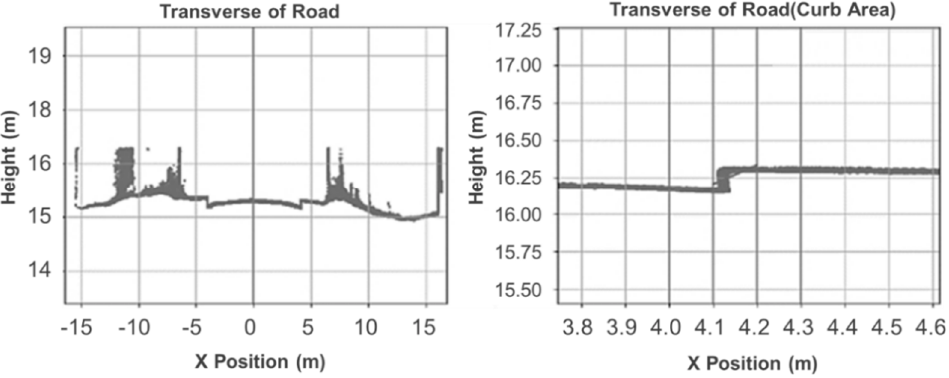
Figure 3. Height-based method for pavement region separation, proposed by Wei [21].